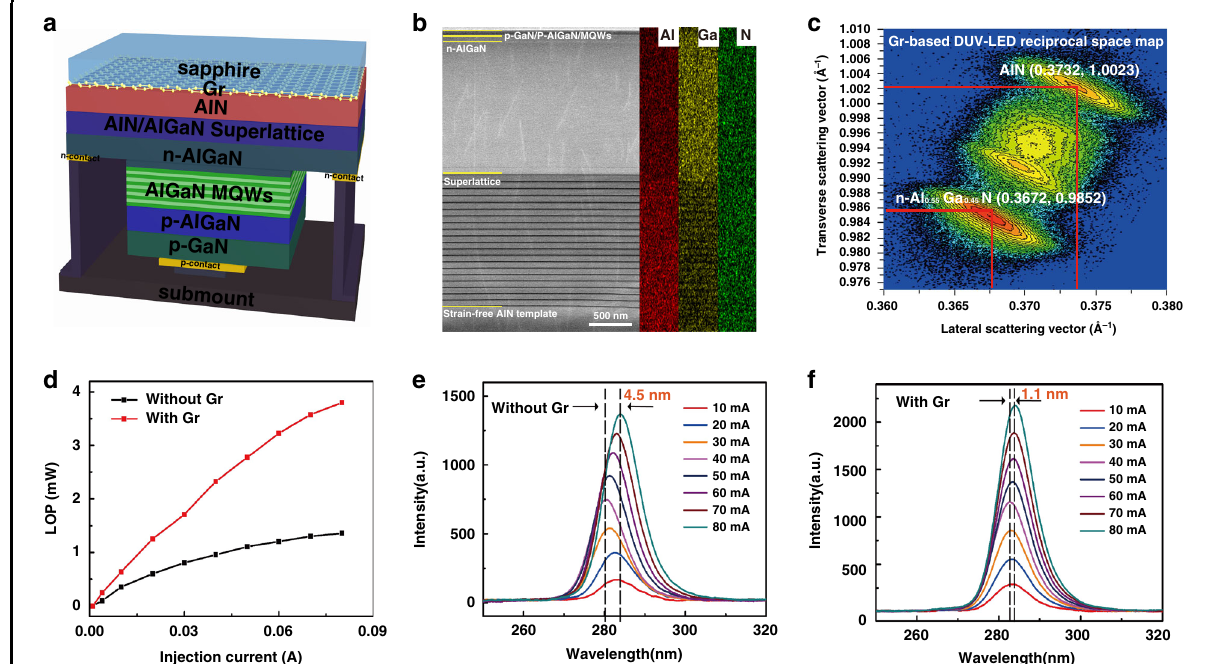
Fig. 6 The structural characterization and EL properties of as-fabricated DUV-LEDs. a Schematic diagram of the DUV-LED structure with Gr. b Cross-sectional STEM image of as-grown DUV-LED with Gr and corresponding EDS mapping images of Al, Ga and N elements. c RSM for the (1015) re fl ection of the DUV-LED grown on Gr/sapphire. d LOP of the as-fabricated DUV-LEDs with and without Gr as a function of the injection current. e EL spectra of DUV-LED without Gr by varying the injection current from 10 to 80 mA. f EL spectra of DUV-LED with Gr by varying the injection current from 10 to 80